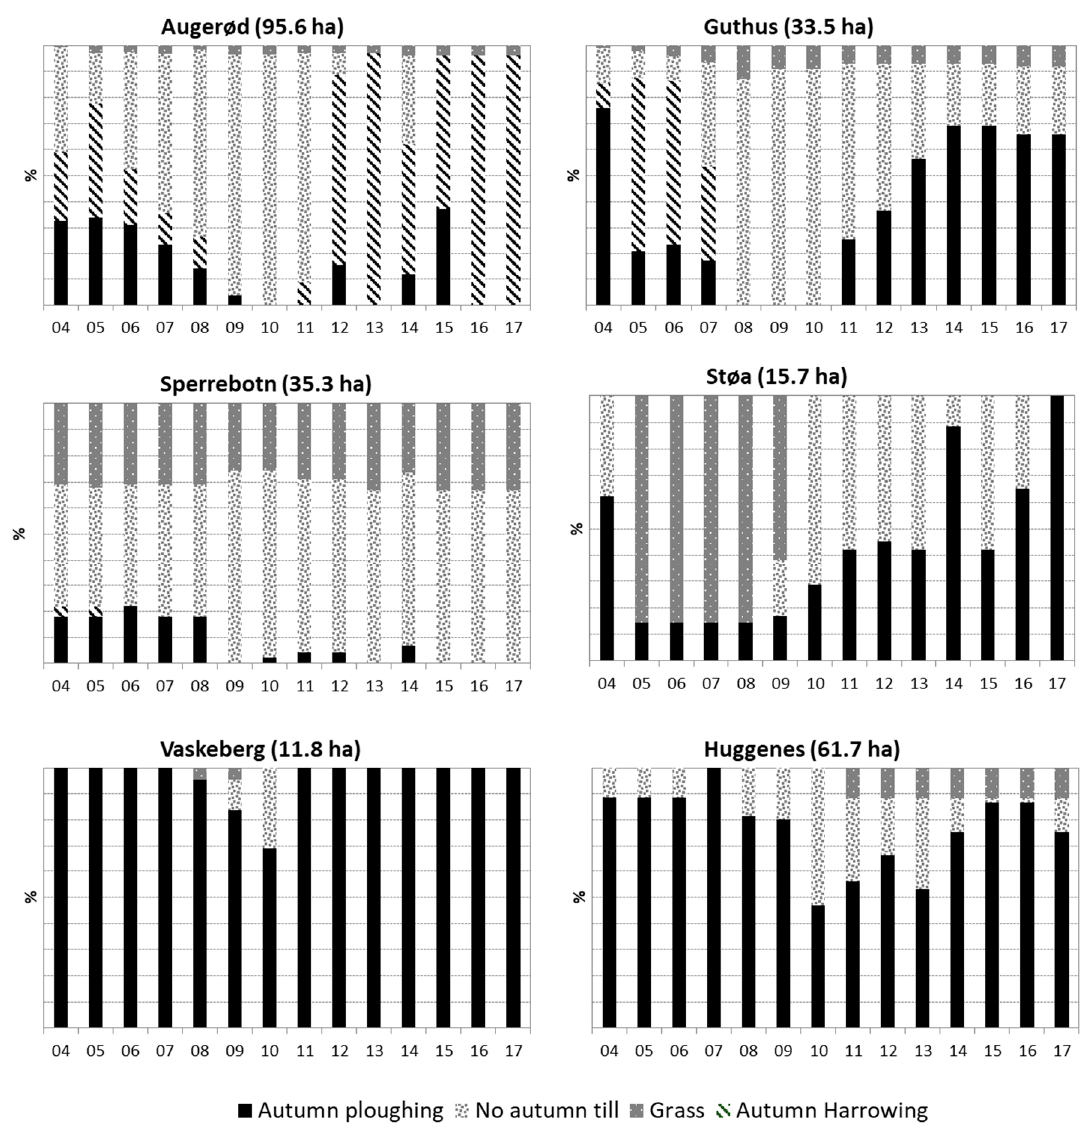
Figure 2. Soil management in the six catchments in the years 2004 to 2010. Arable land (ha) in the catchments are shown in brackets, and years are on the x -axis. Grass includes all grass-covered areas. Table 4. Average 1 P fertilization 2 for farms with contracts in the different catchments. nd = no data.